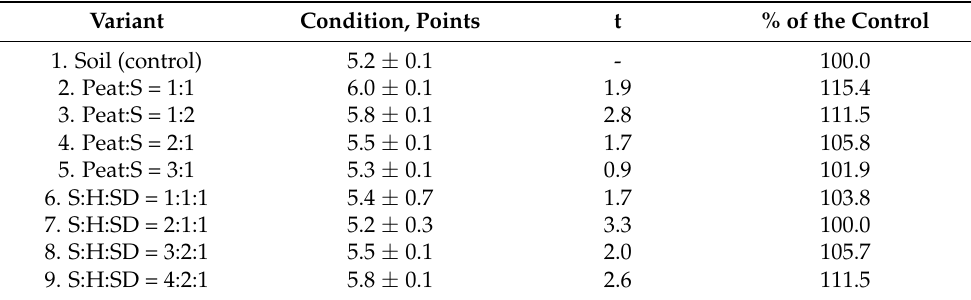
Table 4. Condition of one-year oak seedlings in